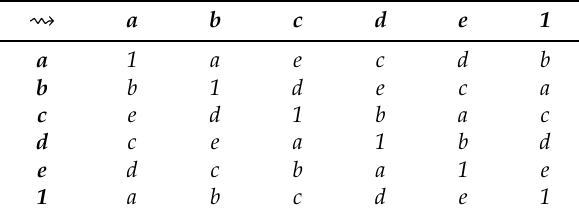
Table 7. The operation (cid:32) on X